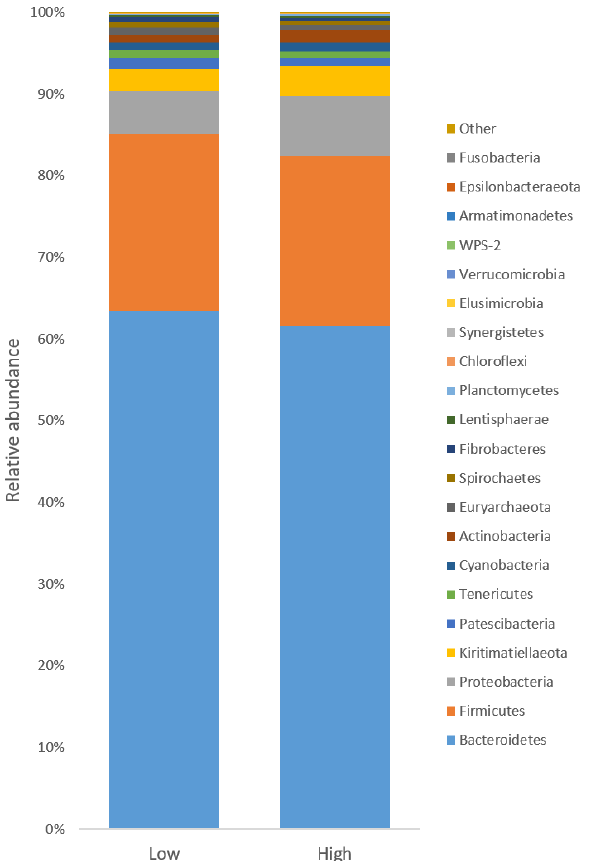
Figure 1. Relative abundance of all sequences at phyla level in low and high